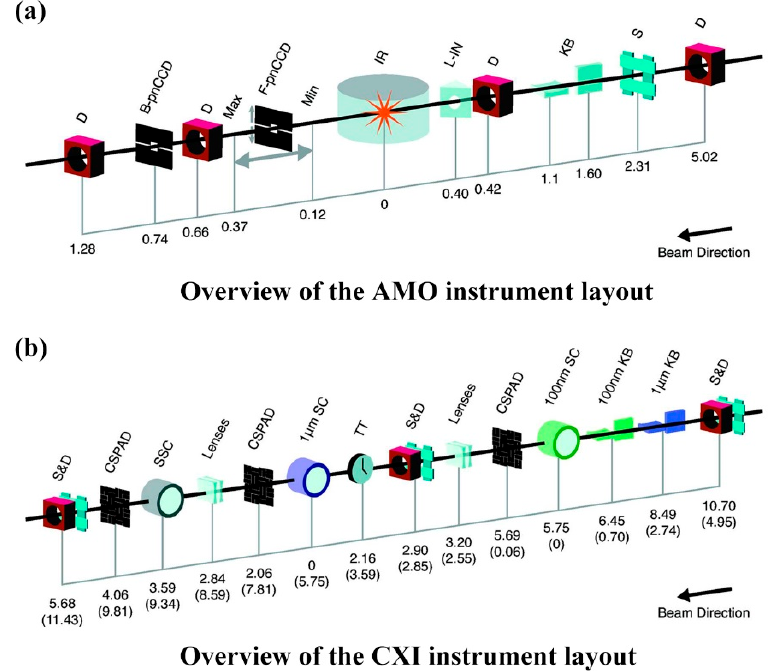
Figure 5. Overview of Atomic, Molecular & Optical Science (AMO) and Coherent X-ray Imaging (CXI) instrument layout. Distances are indicated in meters from the interaction region (IR) for AMO, 1 µ m sample chamber (SC) and in parentheses from the 100 nm SC for CXI. The X-ray beam enters the hutch and passes through the diagnostics (D) and slits (S) and is then focused by KB mirrors. ( a ) An optical laser in-coupling (L-IN) is located 0.4m upstream of the IR. Two pairs of pnCCD detectors are located in different positions downstream of the IR; ( b ) For the CXI instrument, each chamber is colored to match its designed KB mirrors. A timing tool (TT) is designed to obtain the fine time between X-ray laser and pump laser. (Figures were reproduced from Reference [145,146] with permission from International Union of Crystallography/IUCr).